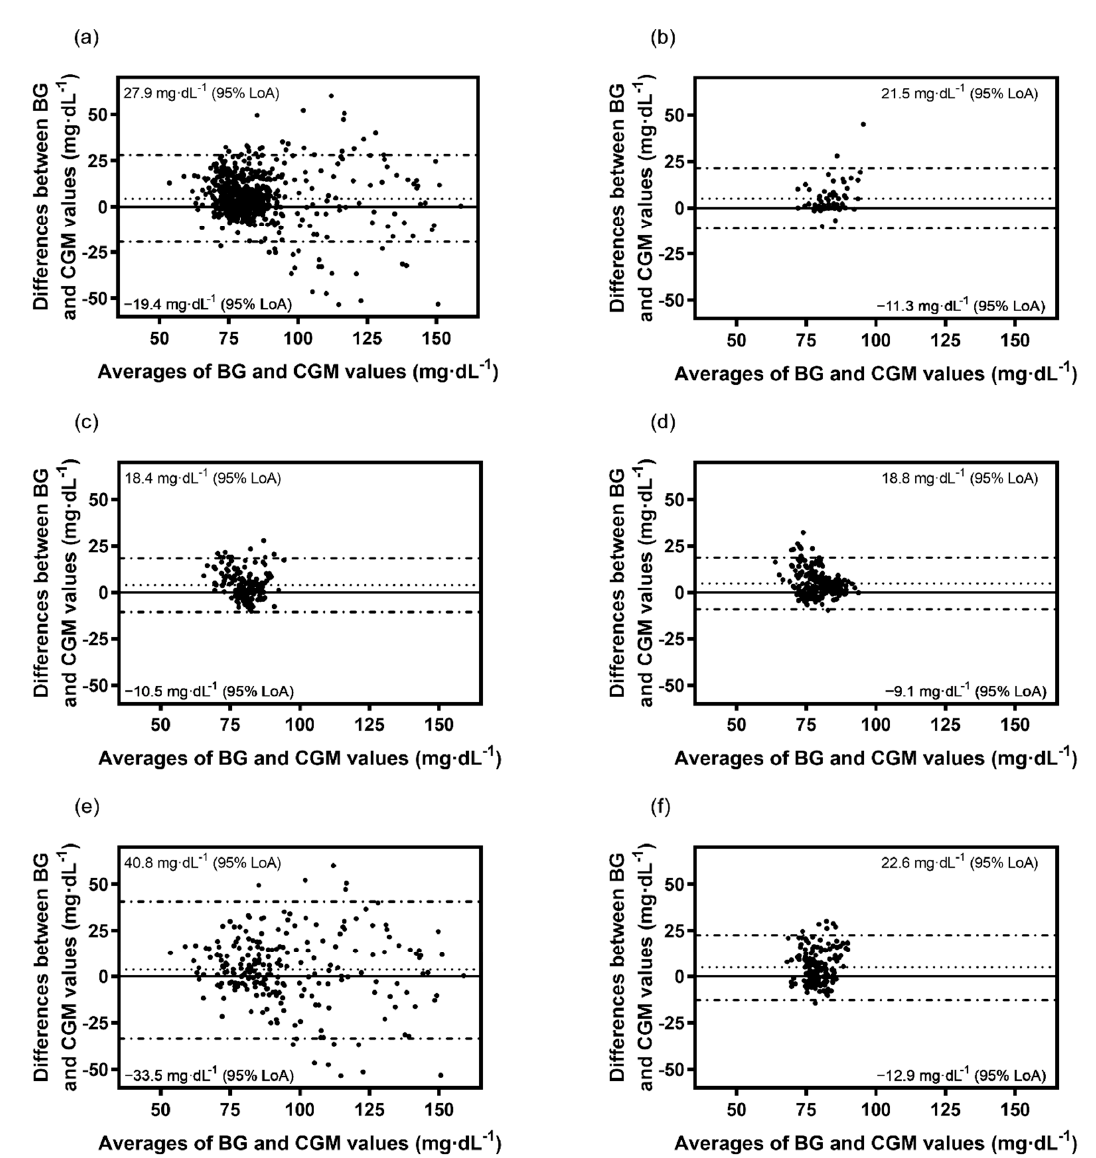
The Bland-Altman method derived bias ± SD of bias and levels of agreement for ab- solute values of glucose for overall, sodium chloride, 5% glucose, Ringer’s solution and the control condition (rtCGM to BG) were found to be 4.3 ± 12.1 ( − 19.6, 27.9) mg·dL − 1 , 4.8 * Median absolute relative difference is expressed as a percentage. Median absolute relative difference indicates absolute values of difference and thus ignores the direction of the measurement error, but indicates the size of the error expressed as percentage error; n = number of points of comparison.